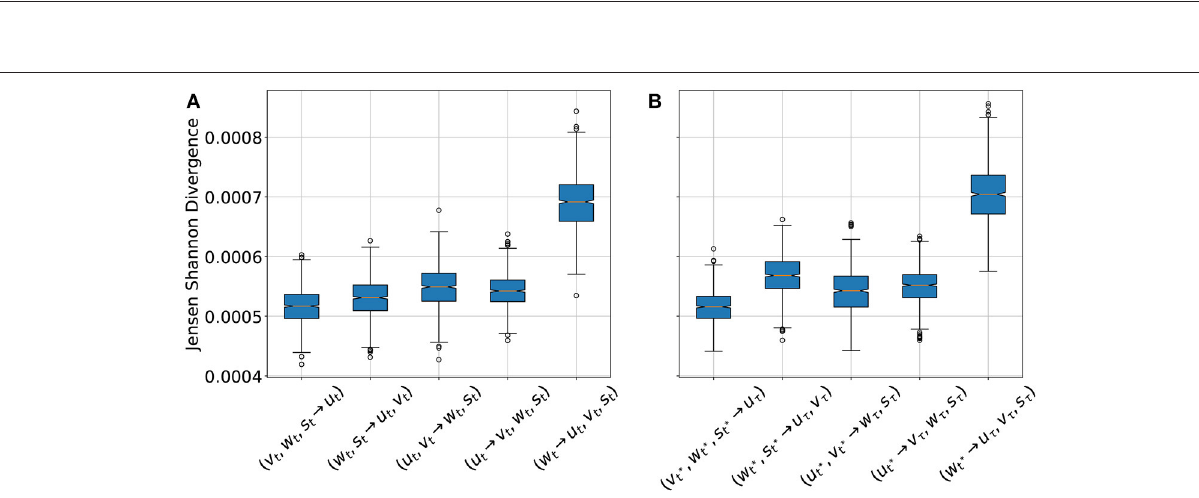
FIGURE 5 | Snapshots of u at different time steps. (A–D) Show the (reference) values from the BOCF simulation, while (E–H) display the values forcasted by the network. The diagrams (I–L) show the absolute deviation of the forecasted values from the reference values. At t = 500 the patterns (A,E) are still (almost) indistinguishable, and for t = 1,500 still only minor differences between (B,F) are noticeable.